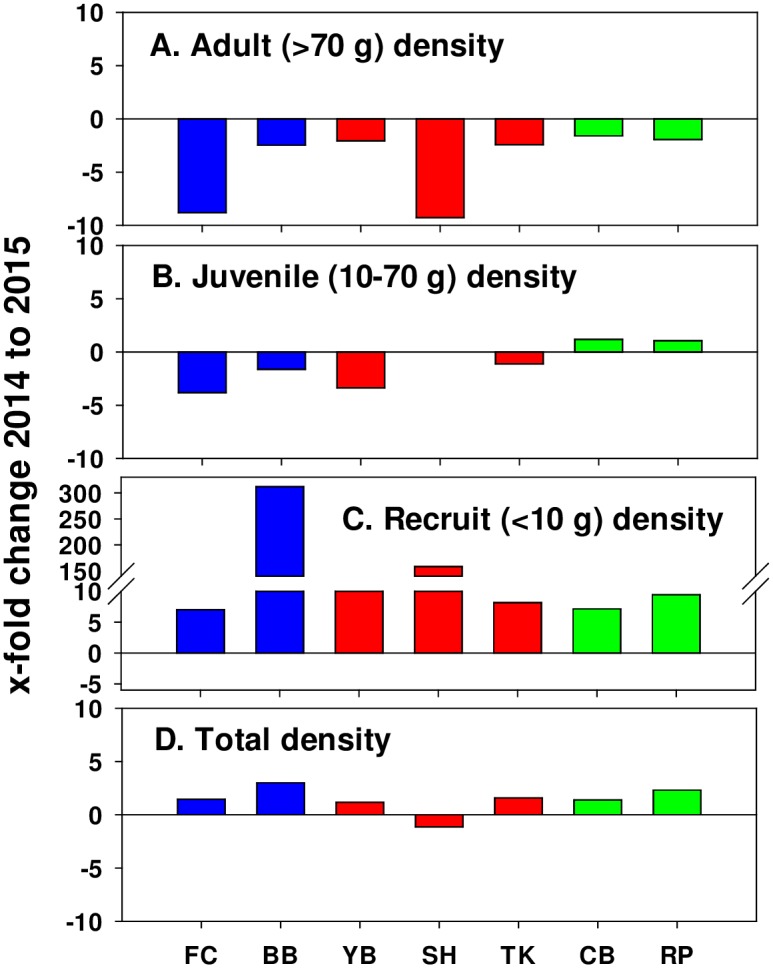
Magnitude of change from summer 2014 to summer 2015 in density (number/m2) of P. ochraceus at seven sites.Sites are color coded by cape, with blue = Cape Foulweather, red = Cape Perpetua, and green = Cape Blanco. A. Change in adult density, B. Change in juvenile density, C. Change in recruit density, D. Change in total sea star density. Weight ranges for each life history stage are approximate, and based on Menge 1974, which found that animals up to ~70g were non-reproductive and animals from ~100 g and larger had ripe gonads (before spawning). See Fig 2 caption for site names.